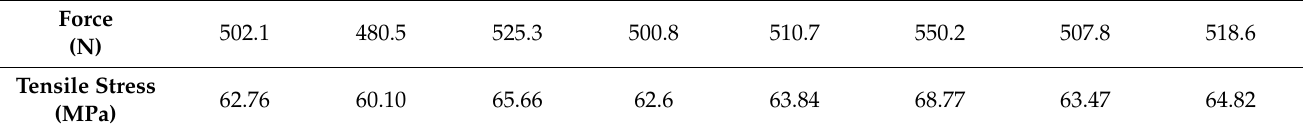
Table 5. Results of experimental verification for tensile strength, obtained with parameter settings from dual-response optimization for LLC scaffolds (Figure 1). Table 6. Results of experimental verification for tensile strength, obtained with parameter settings from dual-response optimization for HLC scaffolds (Figure 2).